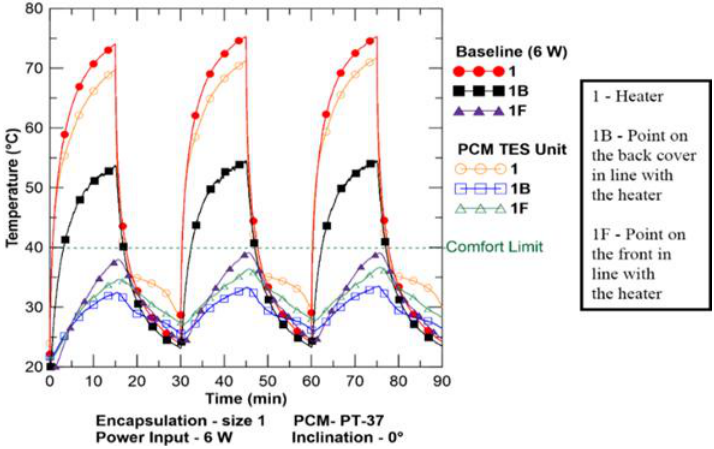
Figure 8. Influence of Size 1 n- eicosane TES unit on the thermal response of the experimental tablet PC at 0° inclination and 6 W power input.